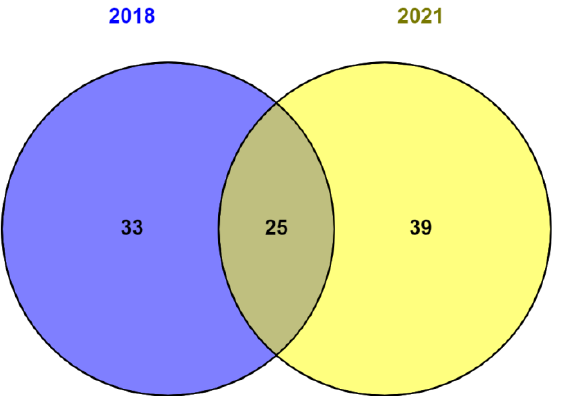
Figure 11. Venn diagram demonstrating number of common and unique protist species in Lake Kislo-Sladkoe in 2018 and 2021.